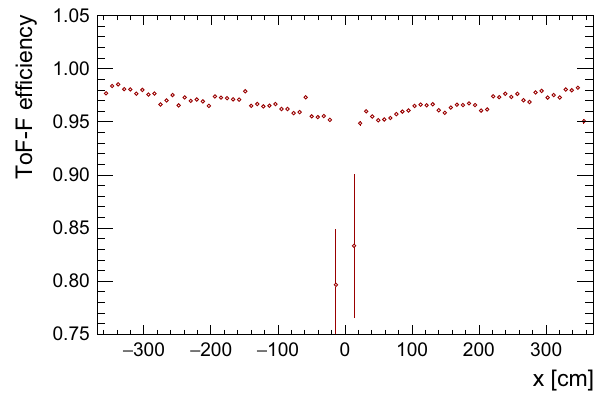
Fig. 16 EfficiencyofthescintillatorbarsintheToF-Fwallasafunction ofthe x -coordinate. Itisclearthattheefficiencydrops ifthebariscloser to the beamline ( x = 0 cm). This is due to an increasing track density with decreasing distance to the beam